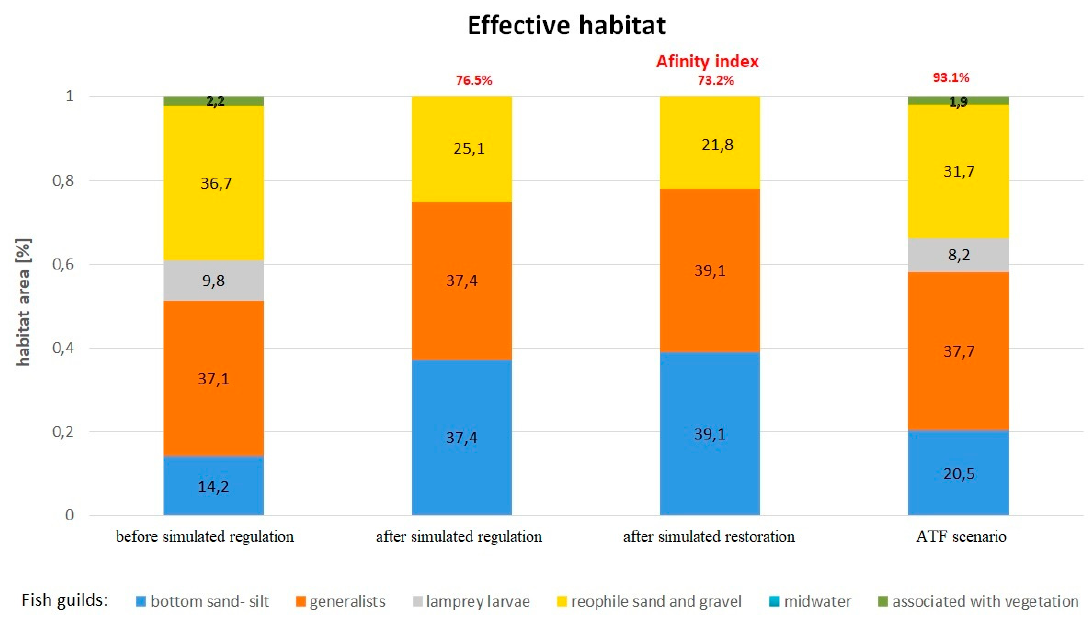
Figure 6. E ff ective habitat area and a ffi nity index for fish guilds on the Swider river section for reference Figure 6. Effective habitat area and affinity index for fish guilds on the Swider river section for conditions and simulated maintenance works, river restoration and ATF reference conditions and simulated maintenance works, river restoration and ATF scenario.